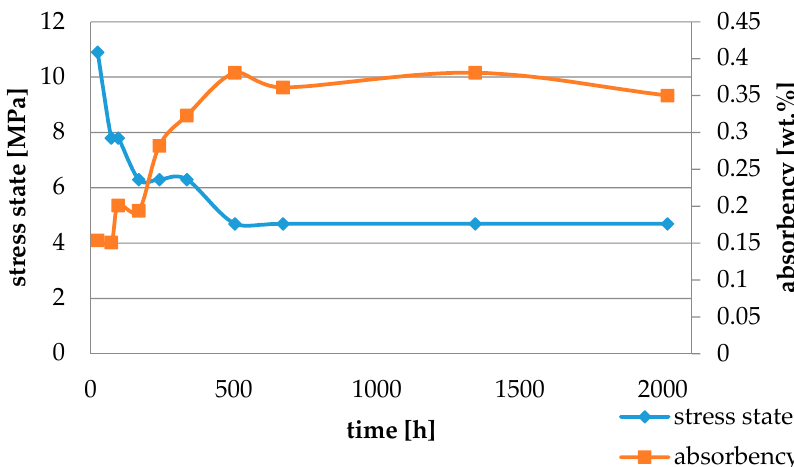
Figure 5. The influence of water sorption (2016 h water ageing) on the absorbency and contraction stress generated during the photopolymerization of Estecem.